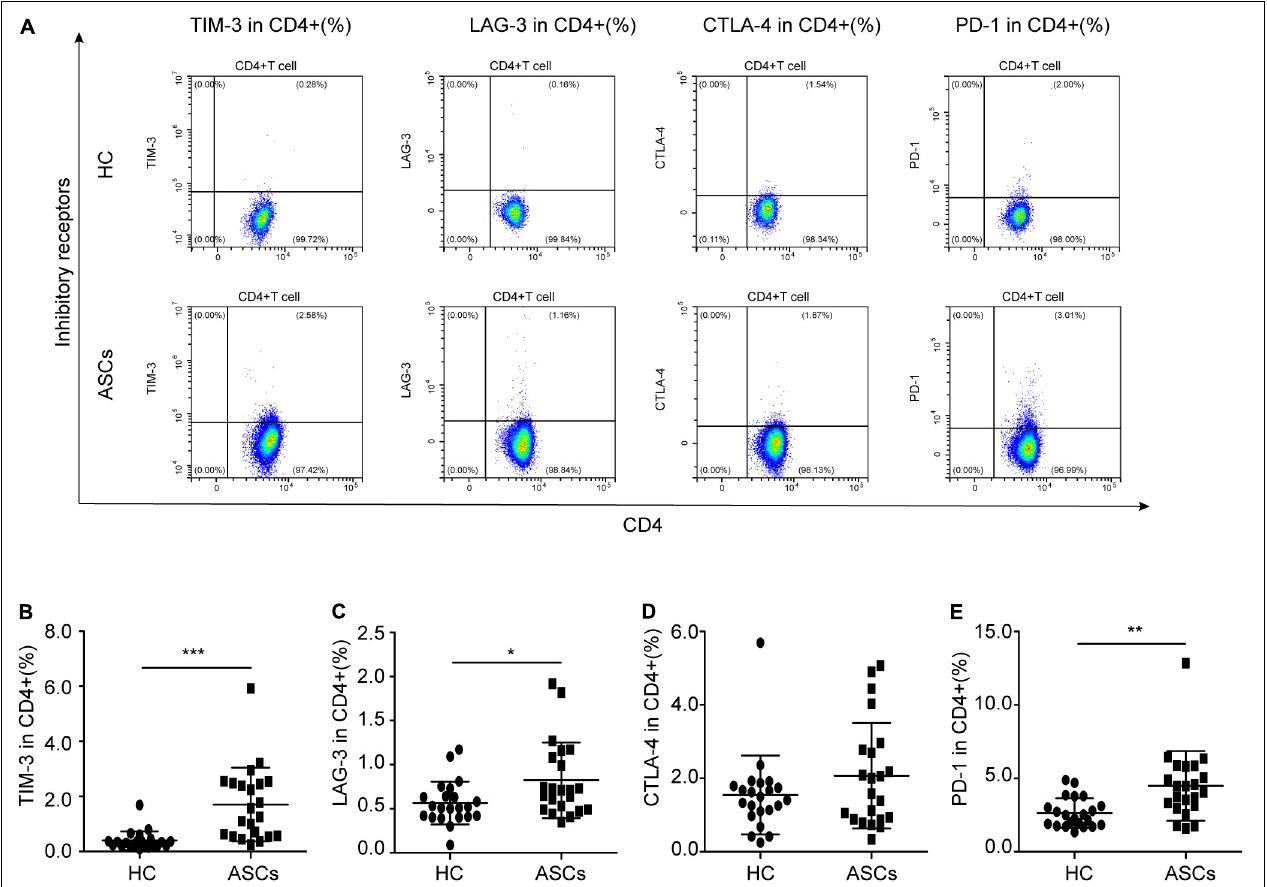
FIGURE 1 | Immune checkpoint molecules expressed on CD4 + T cells in ASCs with HBeAg-negative. (A) Flow cytometry analysis of PD-1 + , TIM-3 + , LAG-3 + , and CTLA-4 + on CD4 + T cells from the PBMCs of HC and ASCs. (B) The frequency of TIM-3 + CD4 + T cells. (C) The frequency of LAG-3 + CD4 + T cells. (D) The frequency of CTLA-4 + CD4 + T cells. (E) The frequency of PD-1 + CD4 + T cells. Data represent the mean ± SD. * P < 0.05, ** P < 0.01, and *** P < 0.001.